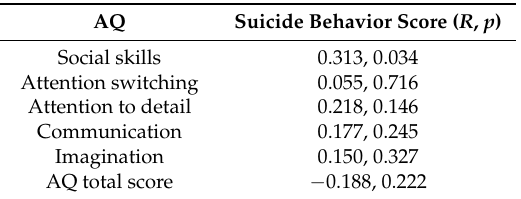
Table 3. Correlation between the AQ domains and total score the TALS-SR suicide behavior score in superior university students with putative